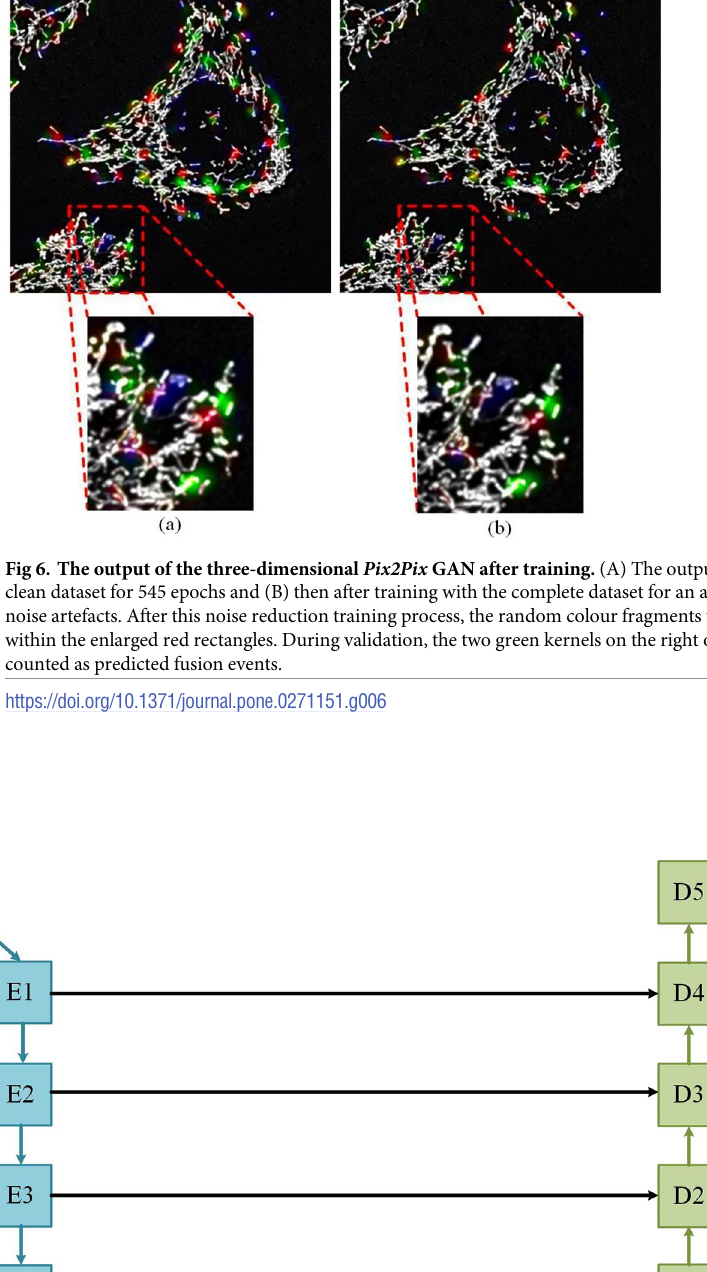
PLOS ONE | https://doi.org/10.1371/journal.pone.0271151 March 8,